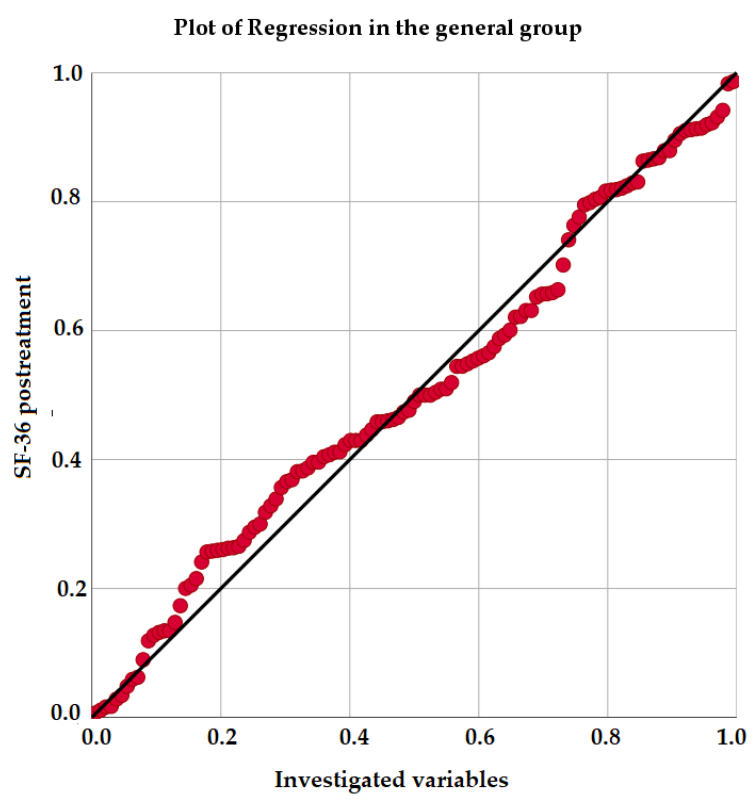
Figure 1. Plot for logistic regression in the general sample. Table 4. Multiple regression analysis’ table: probability of quality of life’s improvement or worsening: relationship be- tween the result in the SF-36 questionnaire post-treatment and the variables.